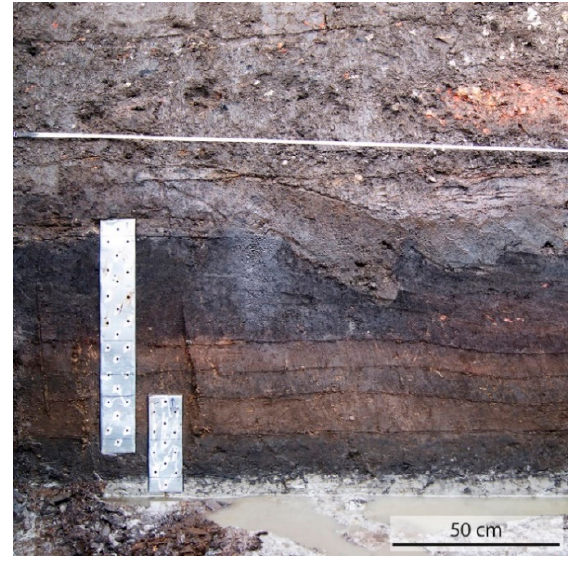
Figure 2. Example of a sampling site: section of the site Vijzeltuin with sample boxes.